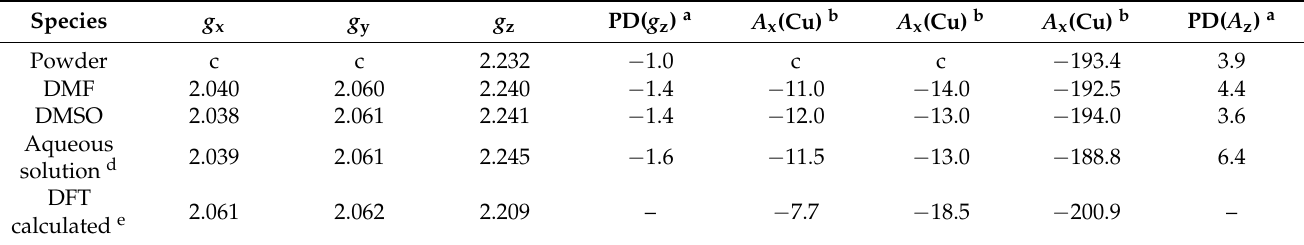
Table 1. Experimental and calculated spin Hamiltonian parameters of [CuLH 2 (OAc)].